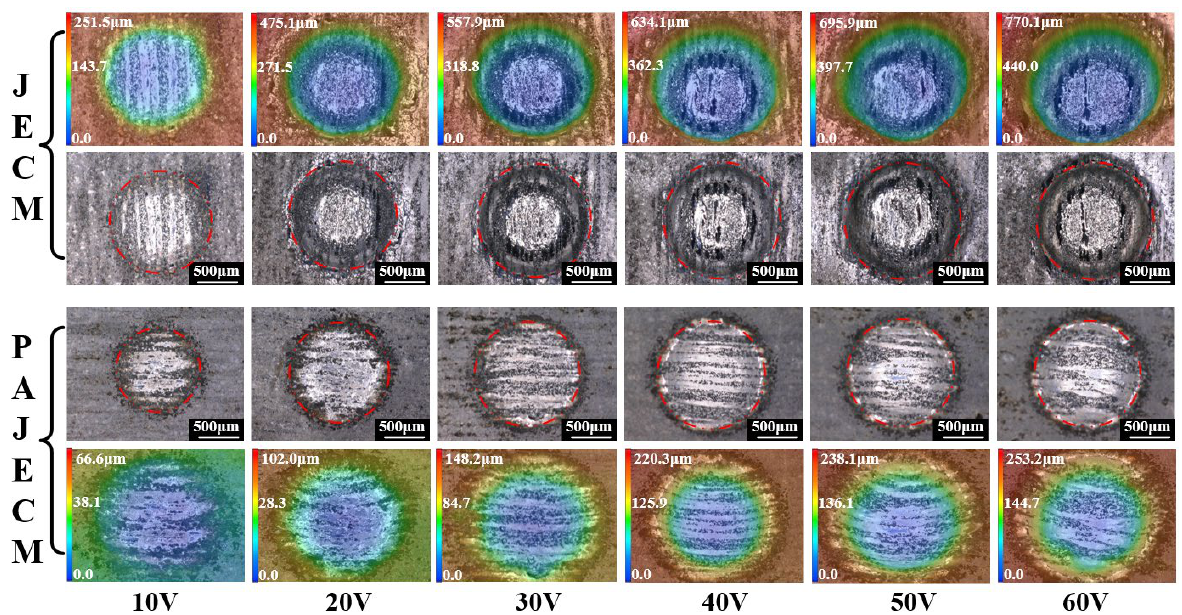
Figure 5. Comparison of surface morphologies processed by JECM and PAJECM at different voltages.